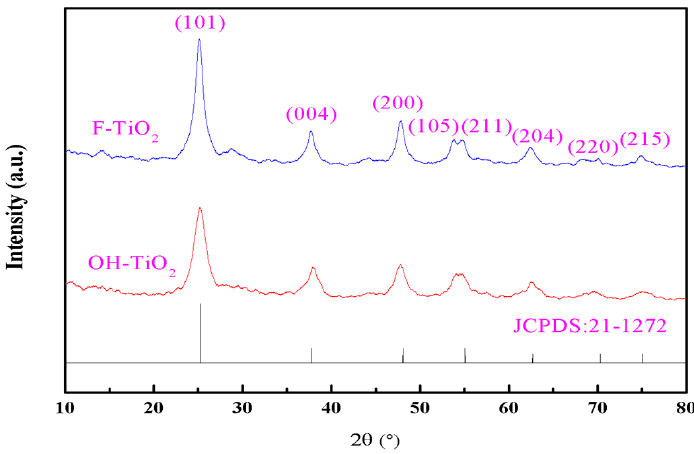
Figure 1. X ‐ ray diffraction (XRD) patterns of as ‐ prepared F ‐ TiO 2 and OH ‐ TiO 2 samples. Figure 1. X-ray diffraction (XRD) patterns of as-prepared F-TiO 2 and OH-TiO 2